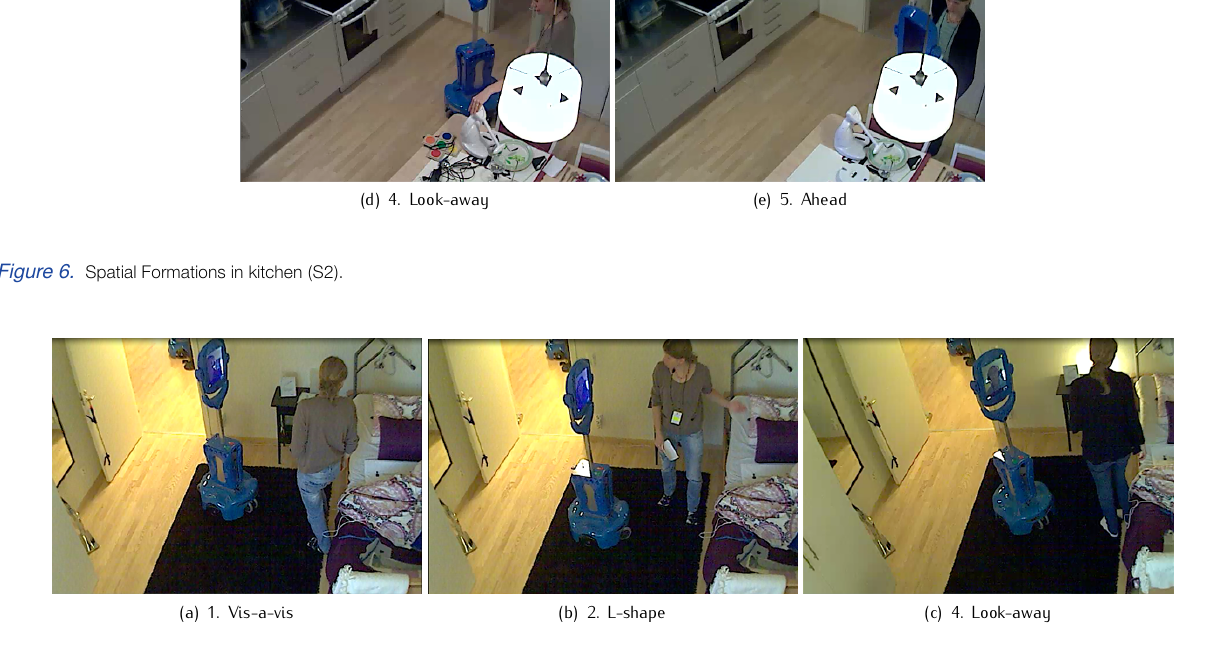
Figure 7. Spatial Formations in bedroom (S3).